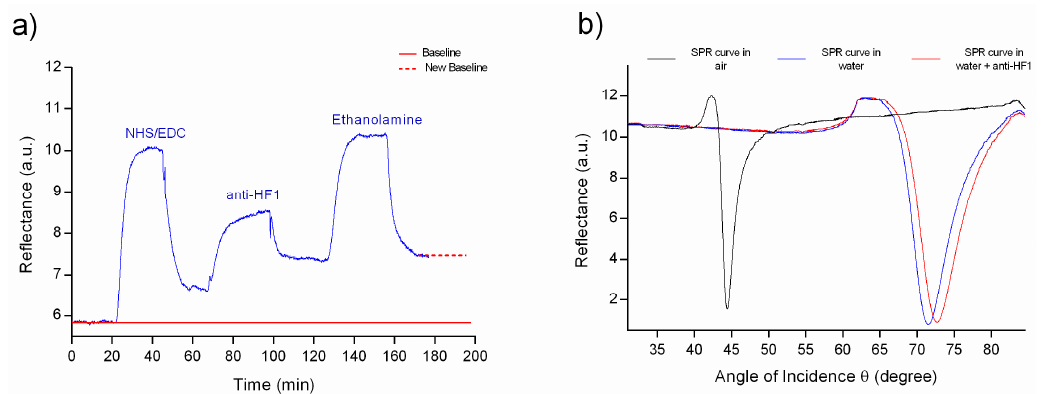
Figure 4. ( a ) Real-time SPR sensorgram of anti-HF1 immobilization. Activation by EDC/NHS; then immobilization of the polyclonal antibodies and finally blocking of the sensor surface by ethanolamine and ( b ) Angular reflectance spectra measured from a sensor chip before (blue) and after the immobilization (red) of anti-HF1.